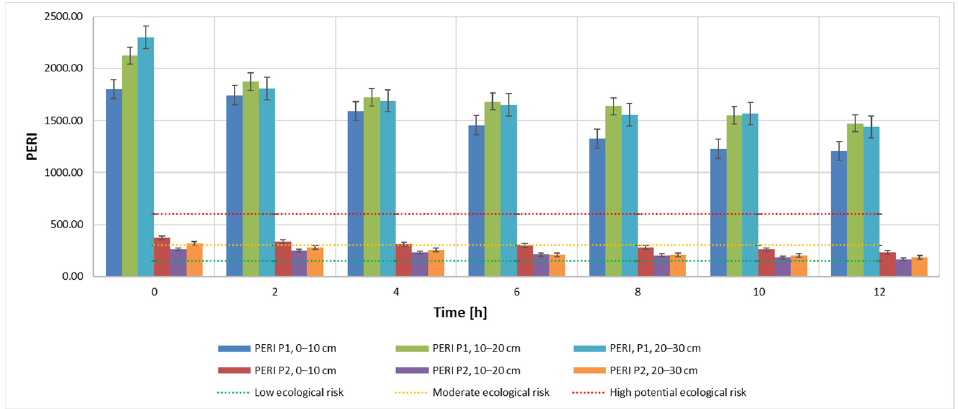
Figure 8. PLI—pollution load index during the extraction process according to admissibility limits and sampling depth using 40 mL 9K medium.